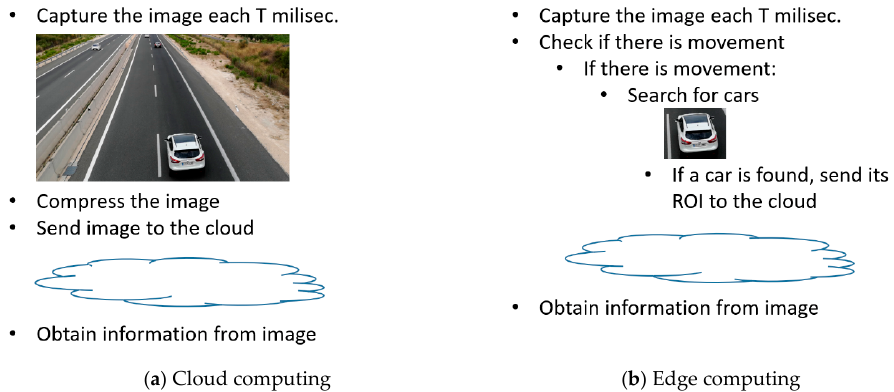
Figure 4. Examples of different behavior on cloud and edge computing.